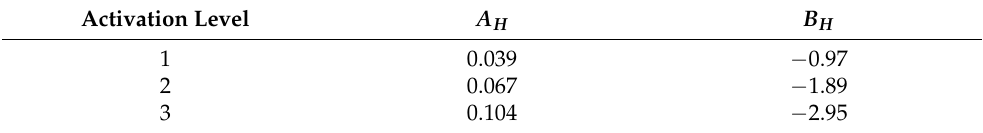
Table 1. Regressed temperature–stroke relationships, as described in Equation (2), by activation level.